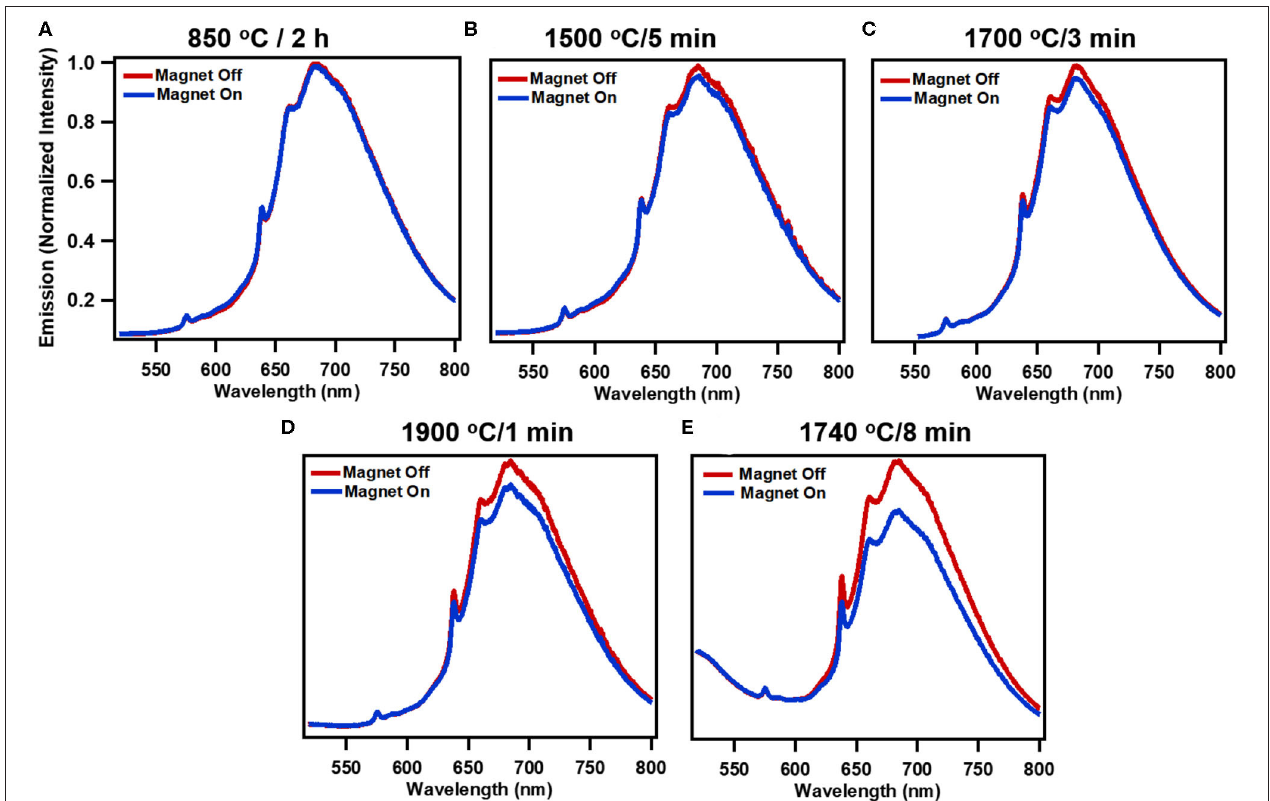
FIGURE 2 | Modulation of fluorescence emission with application of static magnetic field ( ∼ 150 mT) for systematically treated samples: (A) standard treatment (850 ◦ C/2h), (B) 1500 ◦ C/5min, (C) 1700 ◦ C/3min, (D) 1900 ◦ C/1min, and (E) high performing 1740 ◦ C/8min for 514nm excitation. (Spectra are normalized averages of 3 independent